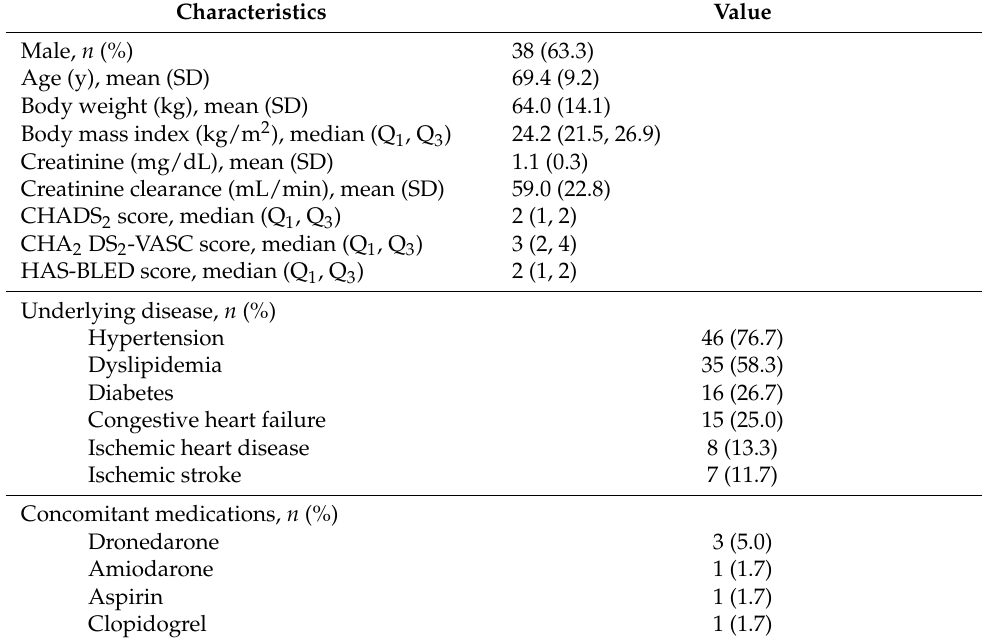
Table 1. Summary of patient characteristics ( n =